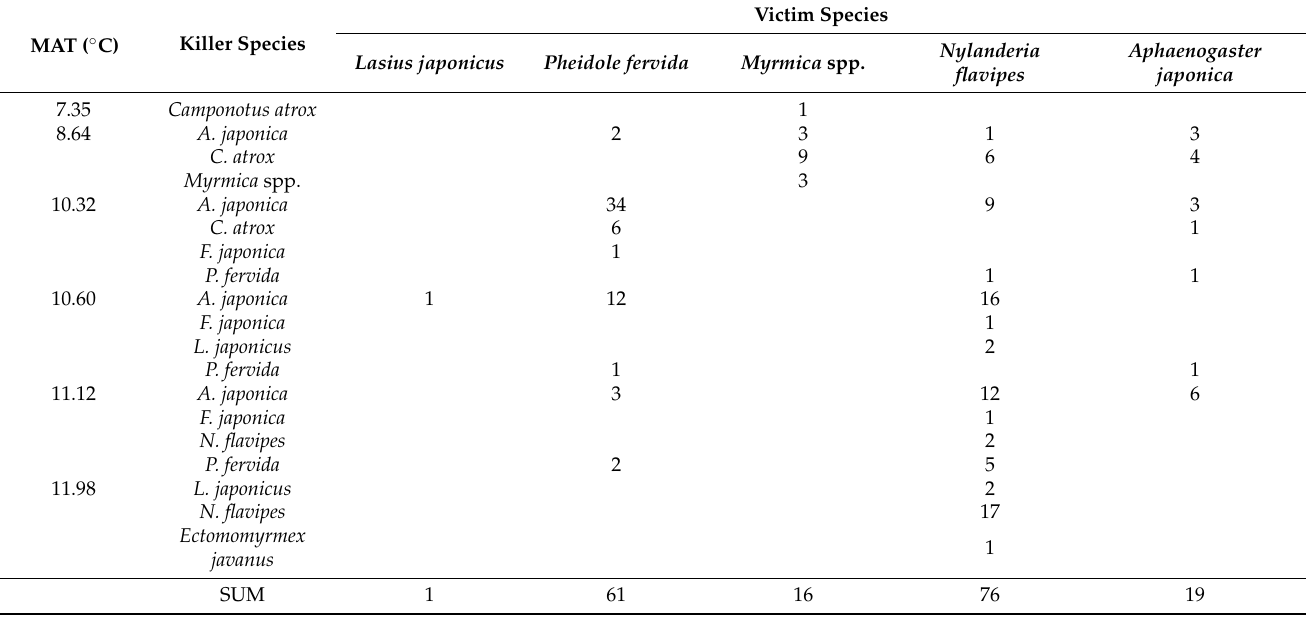
Table 2. Number of ants killed from food competition at six different temperature sites. MAT: mean annual temperature.